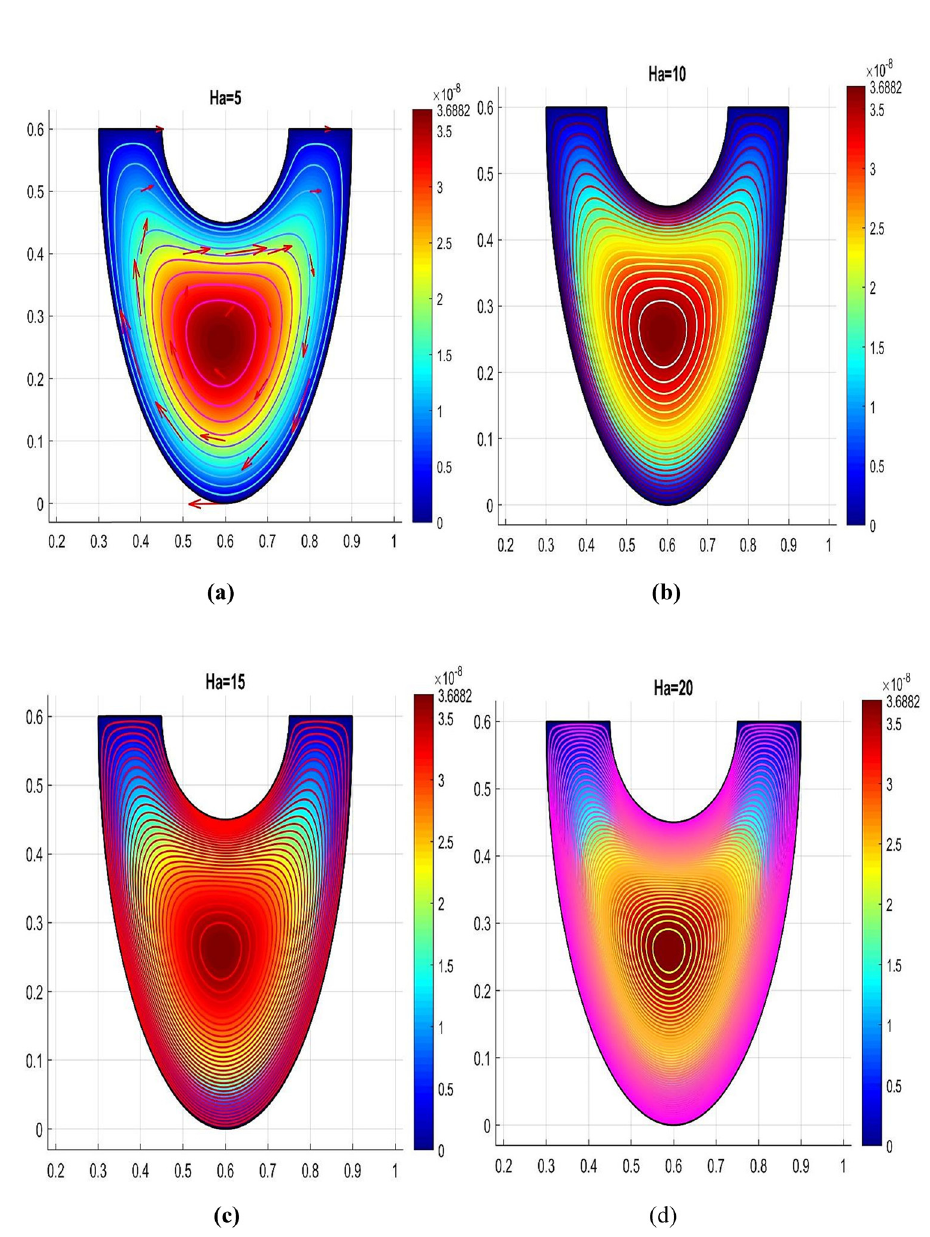
Figure 3: Di ff erent Hartmann numbers for velocity pro fi